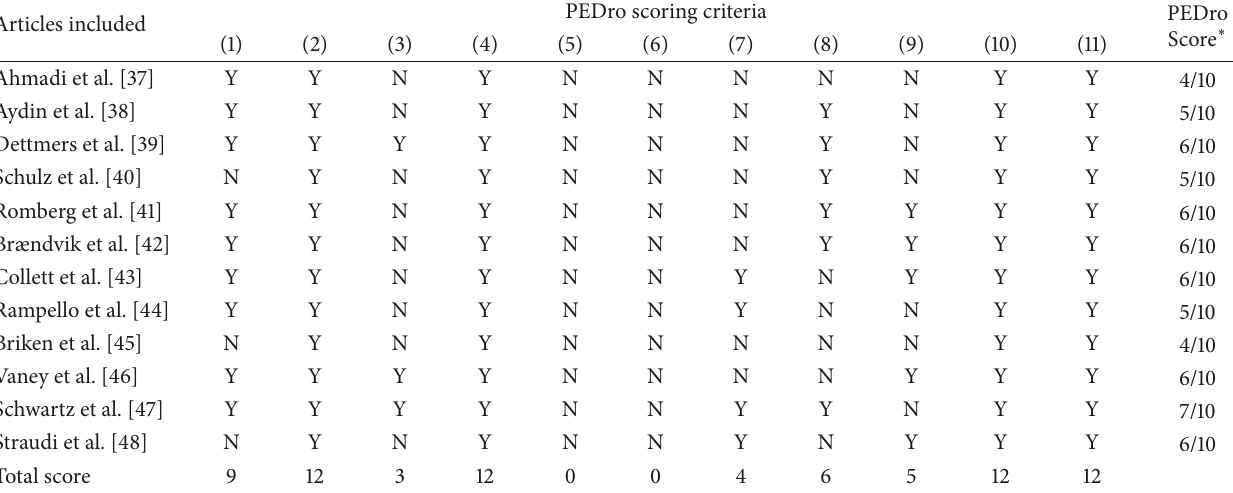
Table 1: Methodological quality assessment of the clinical studies included in this review.